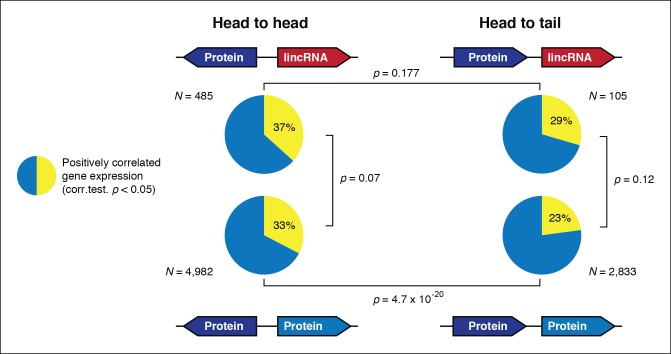
Gene orientation and transcriptional co-regulation of neighboring genes.Distribution of Pearson correlation values between a gene and its upstream neighbor subdivided in four categories. Head-to-head oriented neighbors tend to be more co-expressed than head-to-tail genes, independently of coding potential.